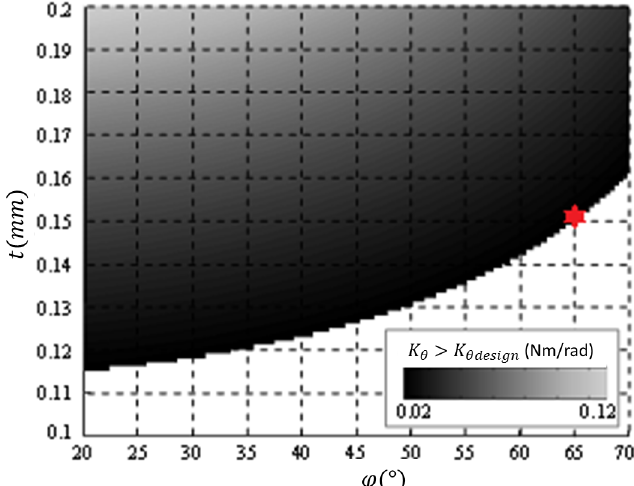
≥ K = 0 . 02 Nm/rad θ θ design